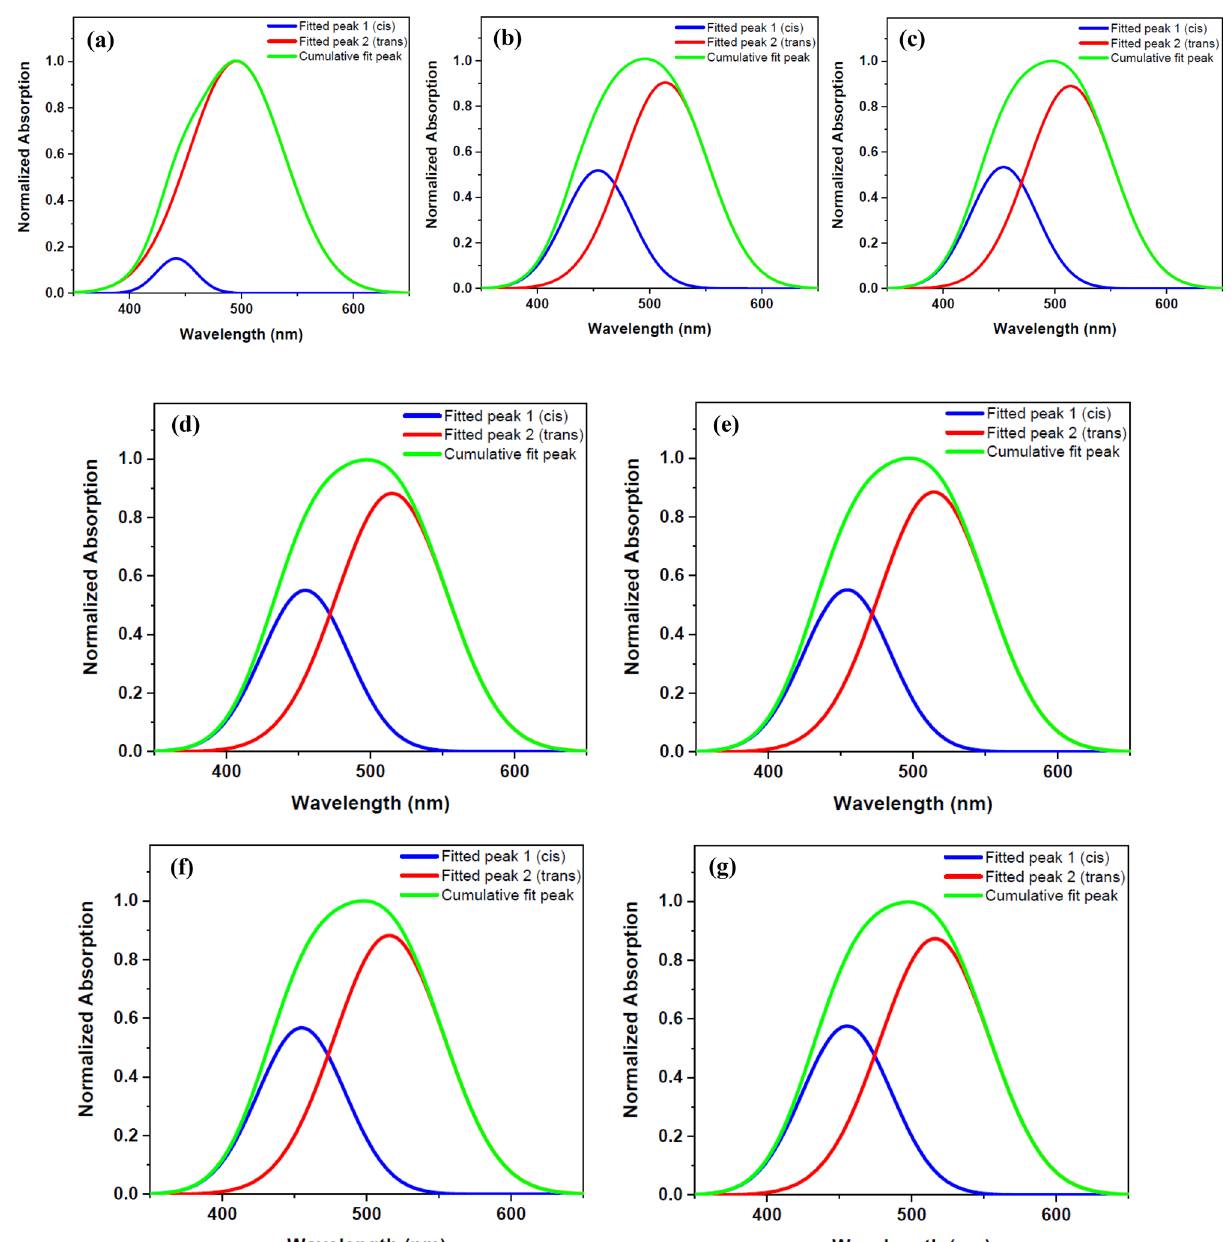
Figure 3. Double peaks fitted for the UV–Vis normalized absorption spectra of DR1 dye-doped PMMA polymer film before and after plasma modification for different treatment times: ( a ) before plasma treatment ( b